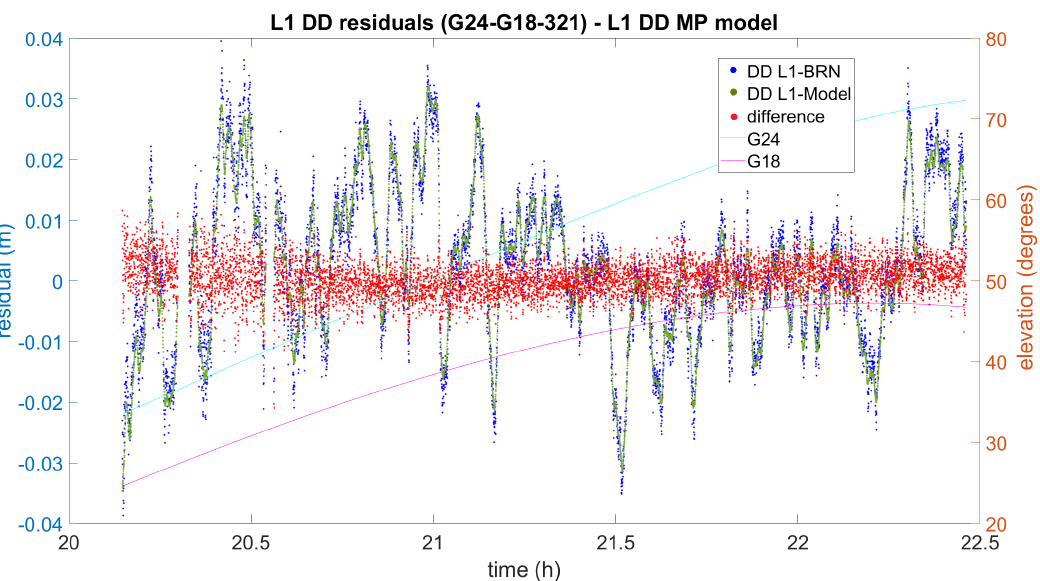
Figure 9. The result of L1 DD multipath mitigation for satellites G24 and G18 (2016 DOY321). DD L1-BRN and DD L1-Model denote the DD L1 residuals obtained by means of Bernese and the use of the Model,